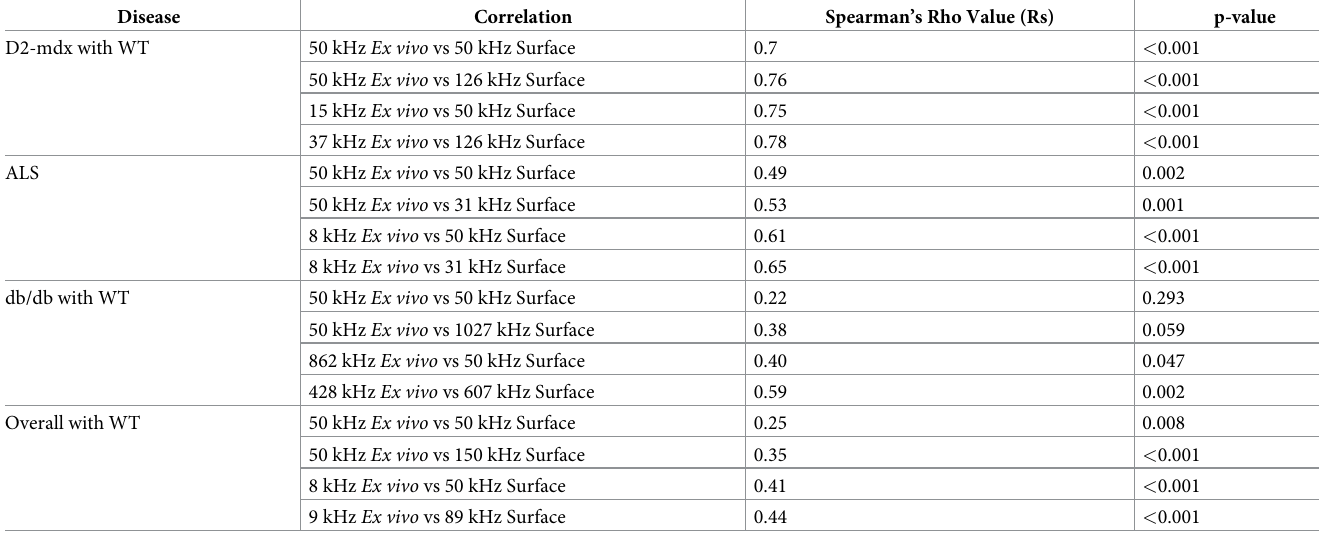
a Correlation coefficients (Spearman’s Rho) and p values for: 50 kHz Ex vivo and 50 kHz Surface impedance measurements, maximum correlation coefficient given